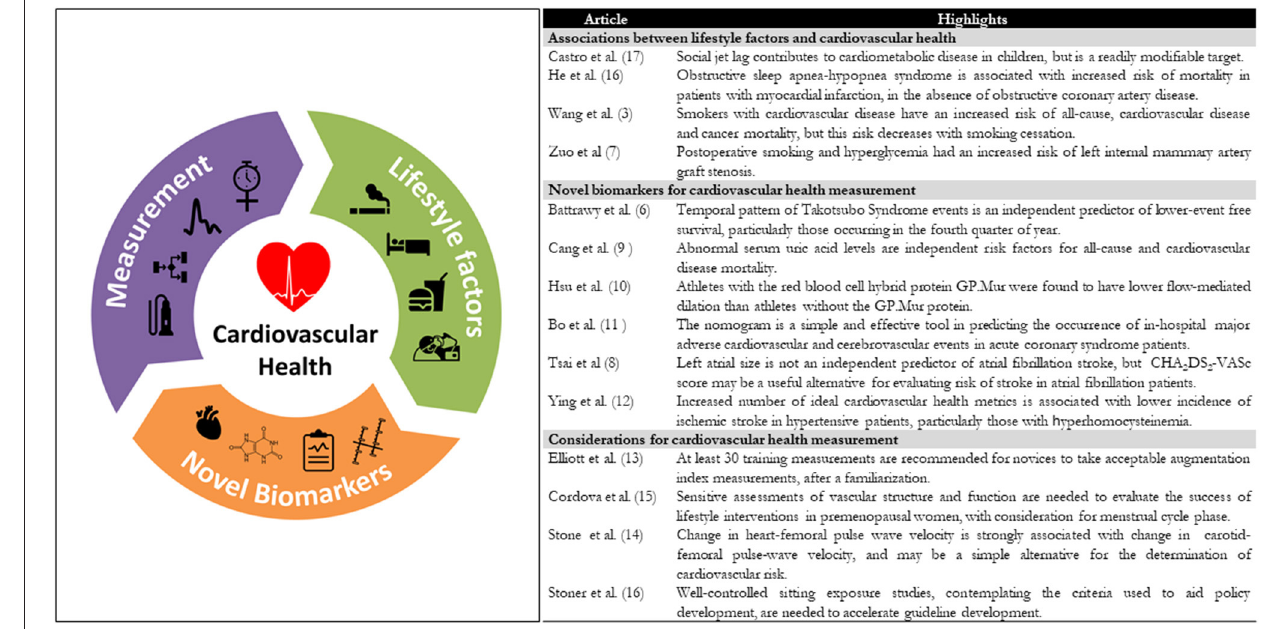
FIGURE 1 | Study highlights for the non-invasive measures of cardiovascular function and health: special considerations for assessing lifestyle behaviors Research